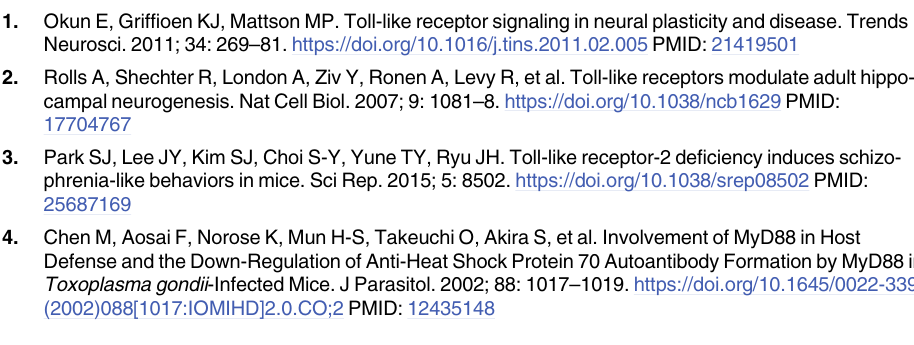
moderate glial cell infiltration, score 3: severe inflammatory cell infiltration, and a T . gondii tis- sue cyst in the brain. TLR2 +/+ mice and TLR2 –/– mice were infected with T . gondii tachyzoites. On day 30 after infection, brain samples were collected. S2 Fig. Analysis of bodyweight changes. Relative body weight changes in the mice were recorded until 28 days post infection. Data are the mean values ± SD for all the mice in each group that were used in two independent experiments (uninfected TLR2 +/+ , n = 16; uninfected TLR2 -/- , n = 13; infected TLR2 +/+ , n = 21; infected TLR2 -/- , n = 18). Significant differences were determined by a two-way ANOVA and post hoc Tukey’s test, and both the infected TLR2 +/+ and infected TLR2 -/- mice showed significant body weight losses from day 9 post infection ( � p < 0.05). S1 Table. Minimal data